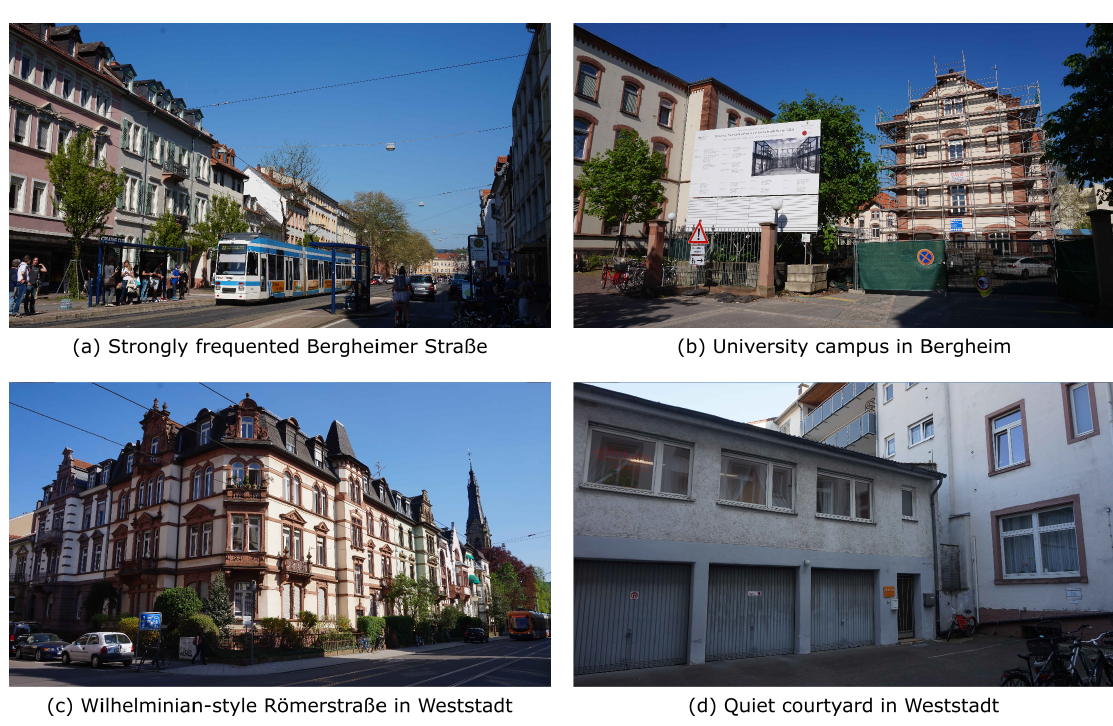
Figure 3. Illustrations of typical scenes found on the playing